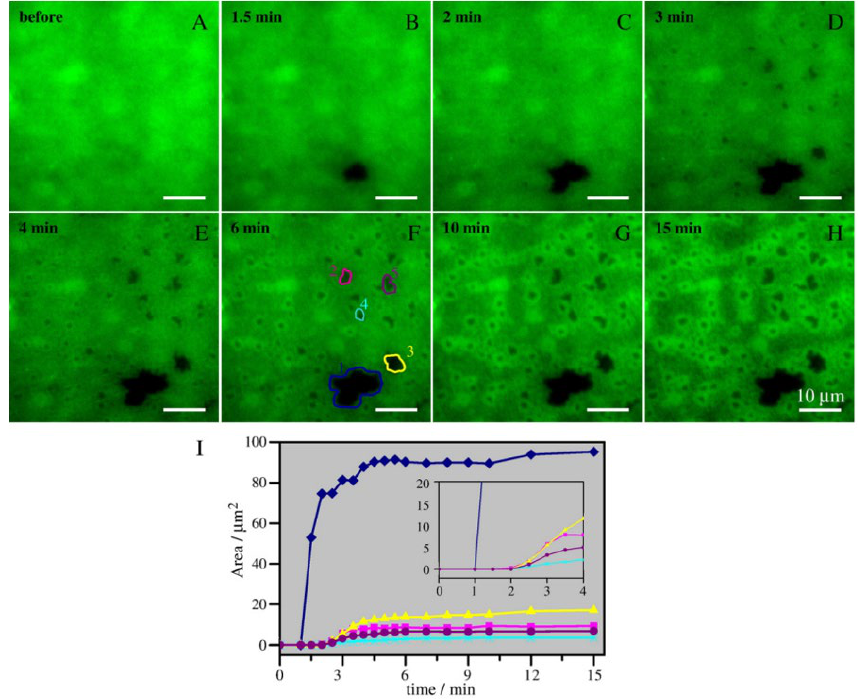
Figure 3. Real-time sphingomyelinase (SMase)-induced coalescence of raft-like ordered domains visualised using total internal reflection fluorescence (TIRF) microscopy. Egg-SM/Chol/dioleoylphosphatidylcholine (DOPC) (5:1:5 in molar ratio) bilayers, which contained 0.5% fluores- cently labelled dipalmitoylphosphatidylethanolamine (a non-raft domain marker), were imaged before ( A ) and at various times after ( B – H ) injection of 1 U/mL SMase. The dark regions correspond to raft-like domains. ( I ) Areas of “domains” 1–5 (outlined in panel F) were plotted as a function of time after enzyme injection; the inset shows initial slopes of the curves. The graphs show expansion of the dark patches during the first 0–15 min. This figure was redrawn from [58] with permission from Elsevier (License No. 5334110330270).